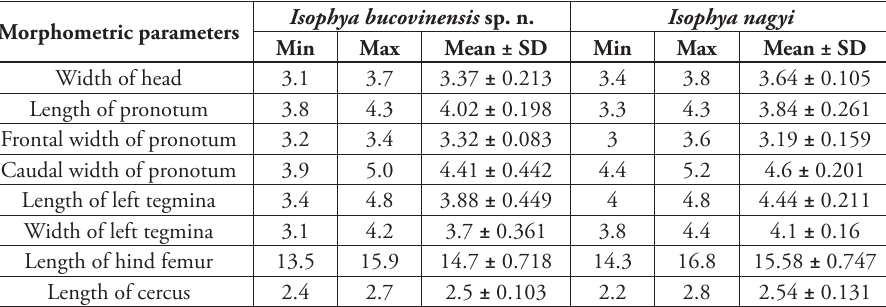
Table 1. Morphometric characters measured in males of Isophya bucovinensis sp. n. (N = 10) and I. nagyi (N = 20) (values in